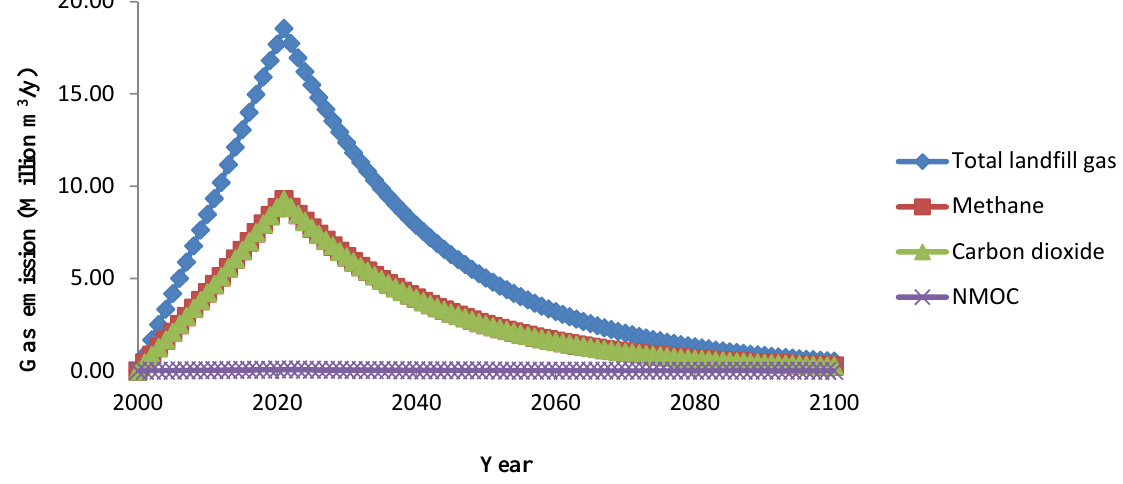
Figure 3. Annual landfill gas volume production provided by LandGEM models (2000-2100) in Sanandaj landfill k = 0.045 (/year), L0 = 200 (m3/ton), non-methane organic compound (NMOC) = 4000 ppmv, methane =